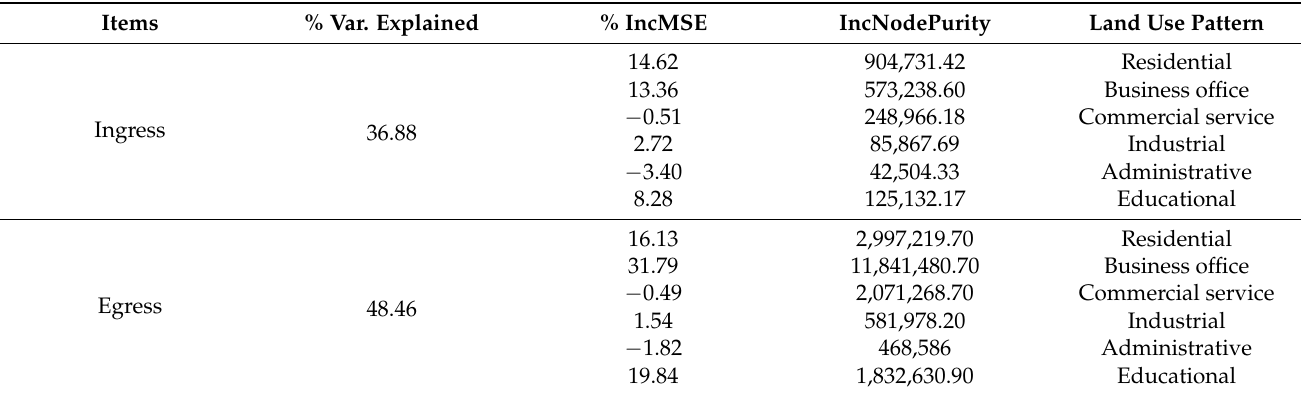
Table 7. The coefficient with random forest